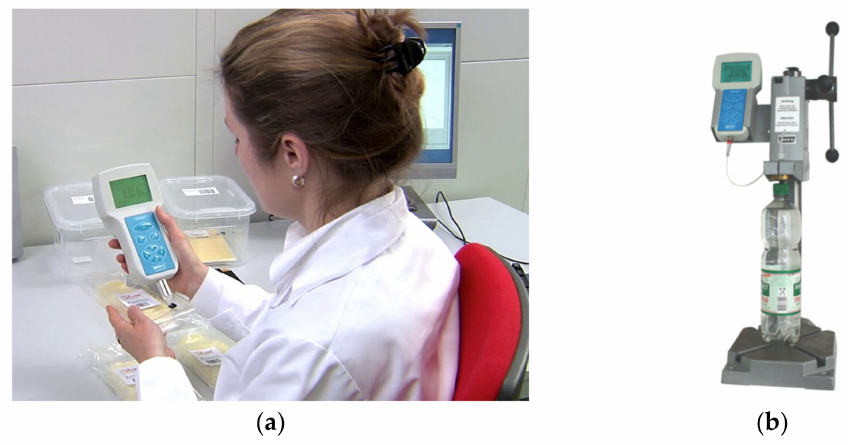
Figure 7. Random needle control. Sample mode analyzer, Oxybaby ®®® : ( a ) container control, ( b ) bottle control, reprinted with permission from WITT